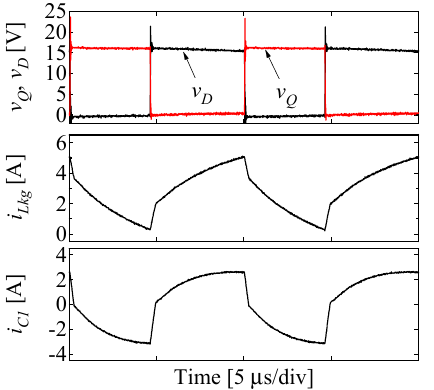
Figure 15. Measured and calculated output characteristic of NRVM.